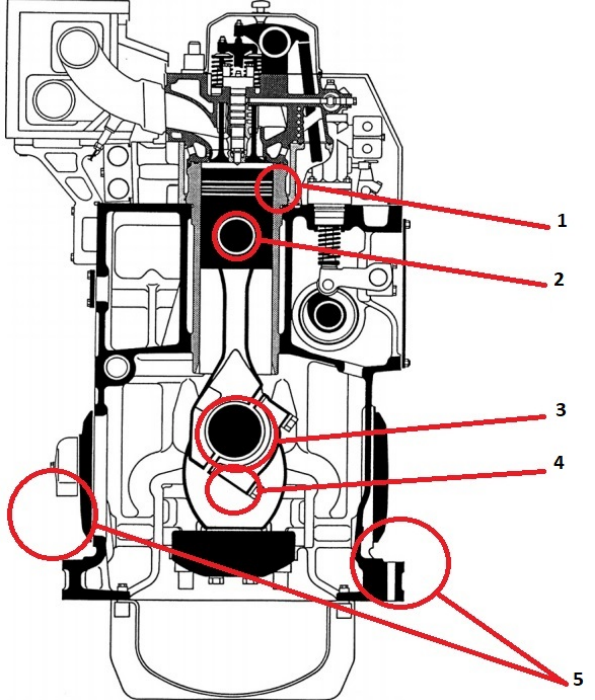
Figure 1. Components of an inline trunk type engine and its surroundings that can cause an explosion in the crankcase [11]: 1—cylinder liner, piston, piston rings; 2—gudgeon pin bearing; 3—crank pin bearing; 4—main bearing; 5—engine environment.